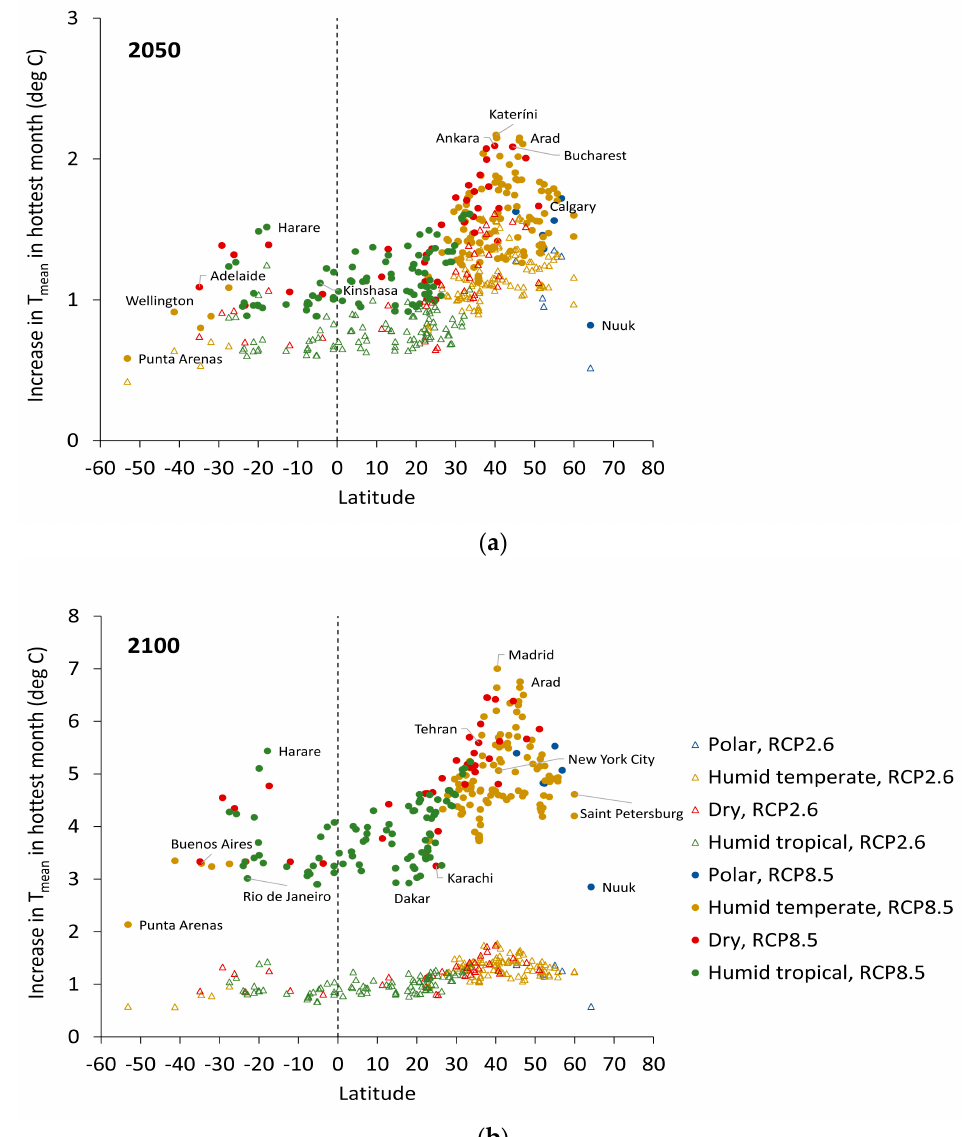
Figure 3. Increase in T mean under RCP2.6 (open triangles) and RCP8.5 (dots) relative to 2017 for the hottest month against latitude by: ( a ) the year 2050 and ( b ) the year 2100. Colouring indicates Bailey’s ecoregion domains.